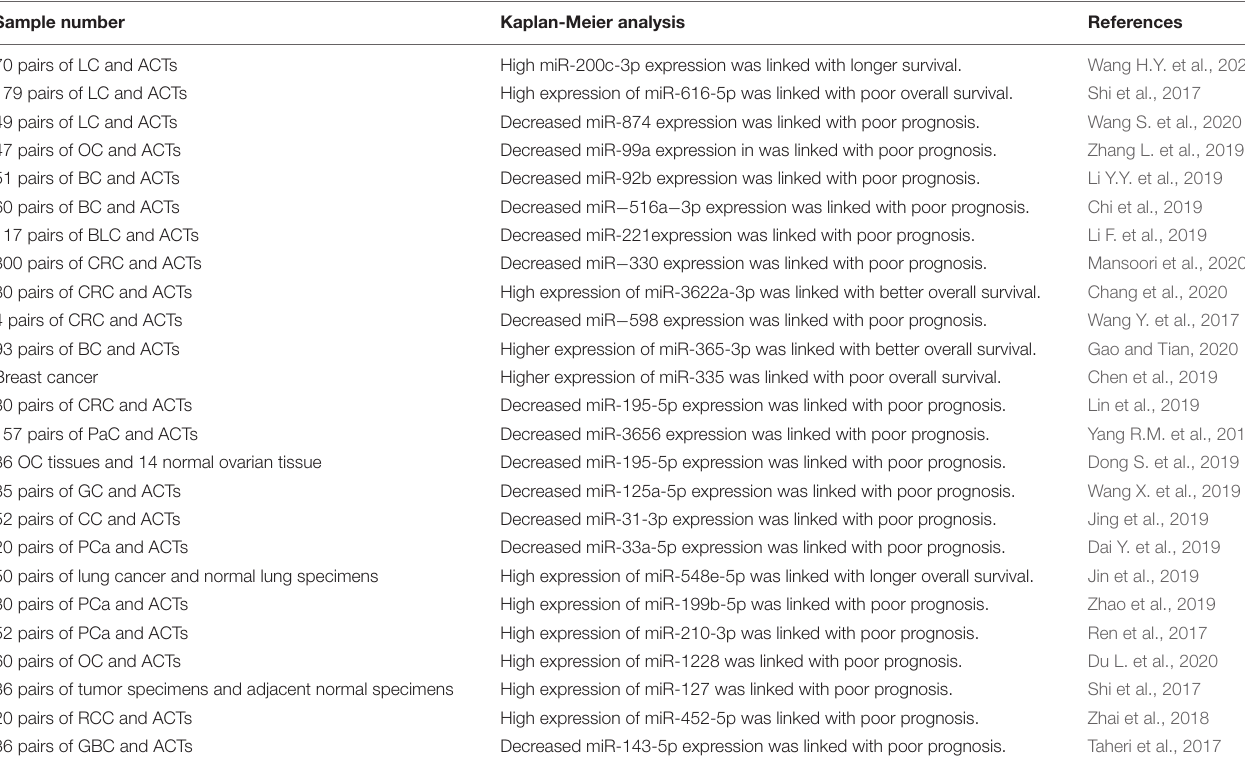
TABLE 1 | Prognostic roles of EMT-associated miRNAs in cancer (ACT: adjacent control